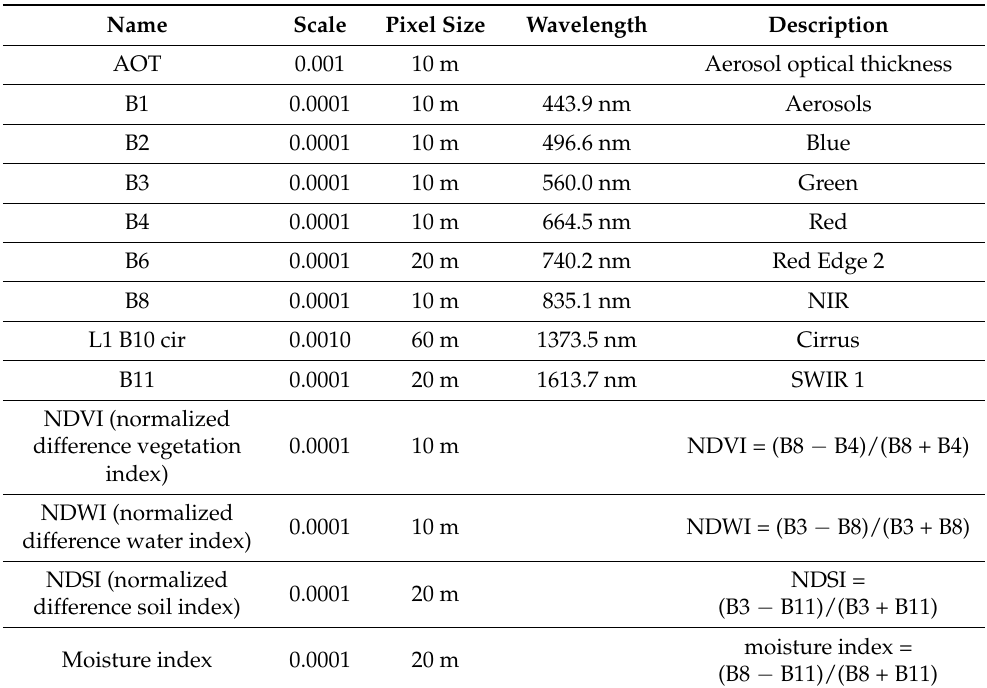
Table 1. List of used satellite spectral bands including normalized difference